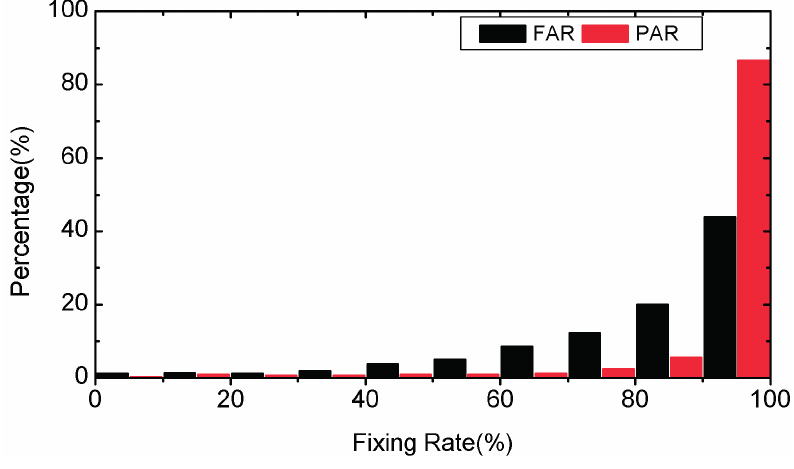
Figure 8. Distribution of fixing rate percentages of kinematic PPP by employing FAR and PAR,